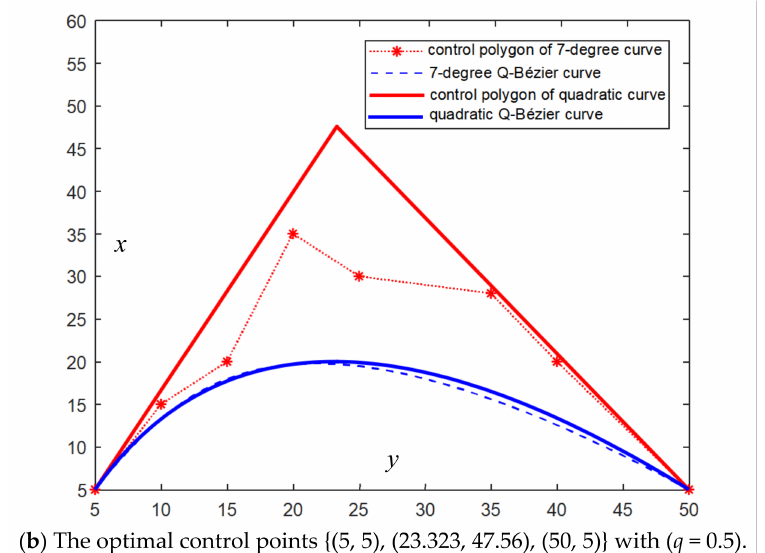
Figure 6. Five-degree reductions of a Q-B é zier curve of degree 7 with the shape parameter q = 1, 0.5. Example 6. Figure 7 shows the two-degree reductions of two Q-B é zier curves of degree 5 and degree 6, whose control points are { T 0 = (0, 0), T 1 = (5, 5), T 2 = (6, 10), T 3 = (10, 8), T 4 = (20, 20), T 5 = (30, 5)} and { T 0 = (0, 20), T 1 = (5, 25), T 2 = (8, 5), T 3 = (15, 20), T 4 = (20, 20), T 5 = (30, 5), T 6 = (40, 15)}, respectively. With q = 0.2, the original Q-B é zier curve of degree 5 (blue dot line) and the approximating Q-B é zier curve of degree 3 (blue solid line) are shown in Figure 7a. Another example for Two-degree reduction of Q-B é zier curves of degree 6 is shown in Figure 7b. As seen from Figure 7, the effect of the two-degree reductions of fifth-degree and sixth-degree Q-B é zier curves are both very good. Furthermore, the changes of the shape parameter q have little effect on the degree reduction results of the curves.